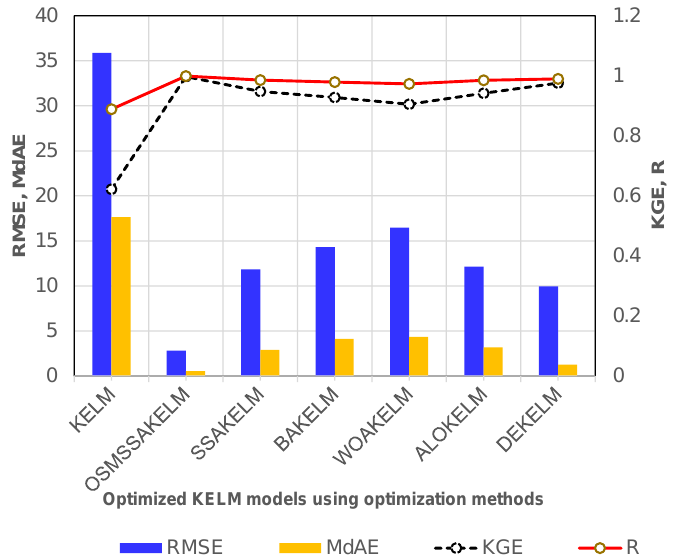
Figure 13. Comparison of optimized KELM models for the training phase based on the RMSE, MdAE, KGE, and R metrics.